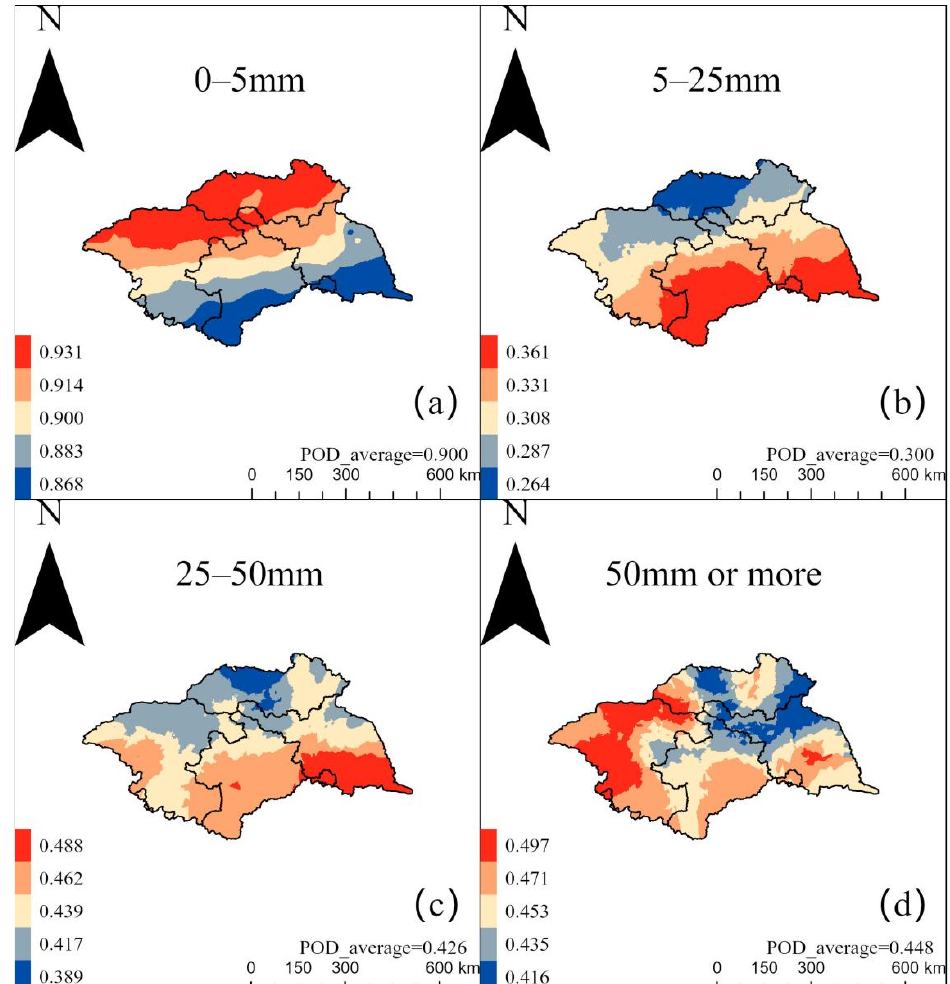
Figure 3. The probability of detection (POD) of daily PERSIANN-CDR estimates in different magnitudes: ( a ) 0–5 mm, ( b ) 5–25 mm, ( c ) 25–50 mm, and ( d ) > 50 mm.